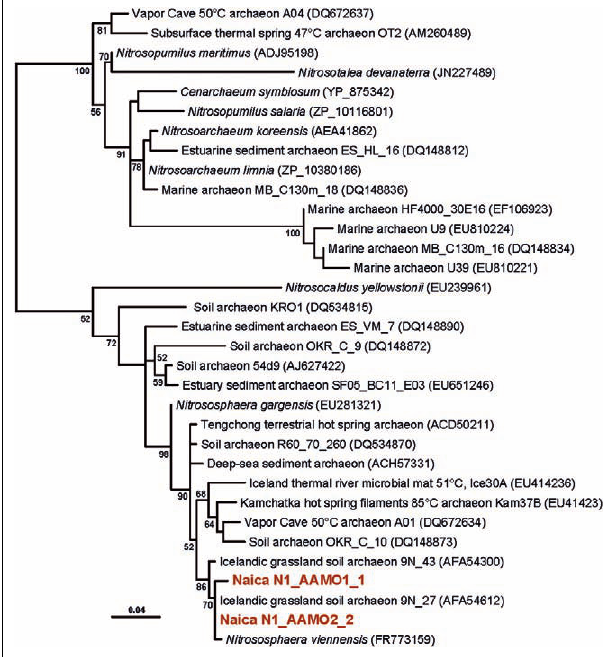
FIGURE 6 | Maximum likelihood tree of archaeal amoA genes retrieved from Naica deep hot springs. The tree was reconstructed using 203 amino acid positions. Sequences obtained in this work are shown in color. Accession numbers of sequences retrieved from GenBank are given between brackets. Only bootstrap values higher than 50% are given at nodes.The scale bar represents the number of substitutions per a unit branch